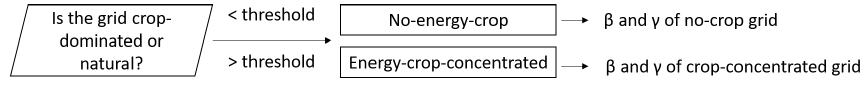
Figure A1. A schematic presentation of the sensitivity study for estimating the carbon–climate feedback parameters over the energy-crop- concentrated and no-energy-crop grids.